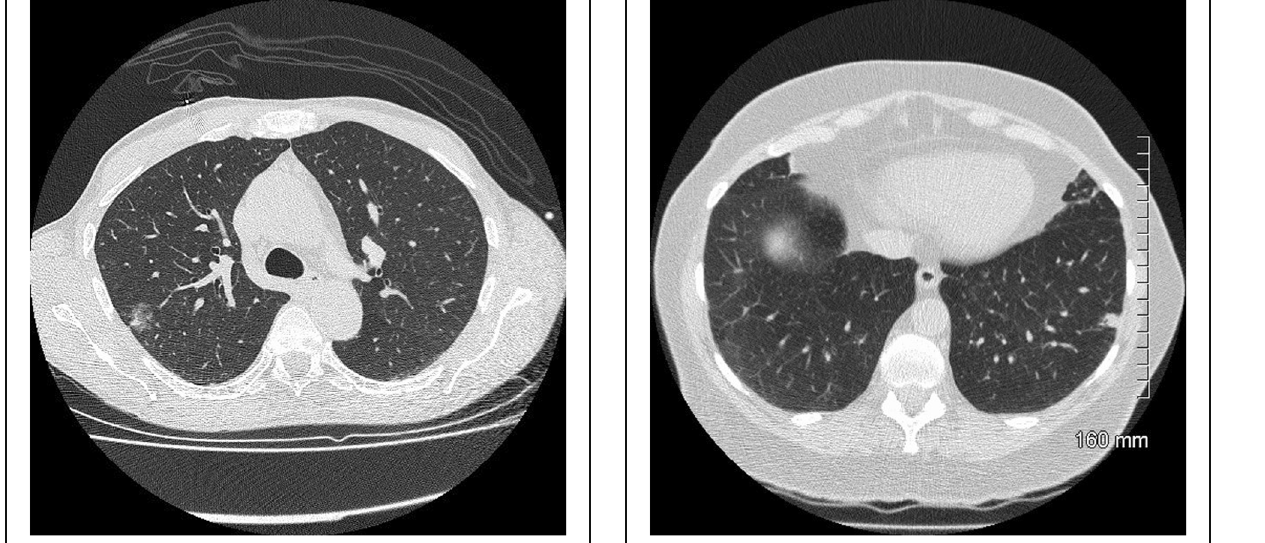
Fig. 4 MIA on CT. A 20-mm part-solid nodule, predominantly ground glass, in the right upper lobe